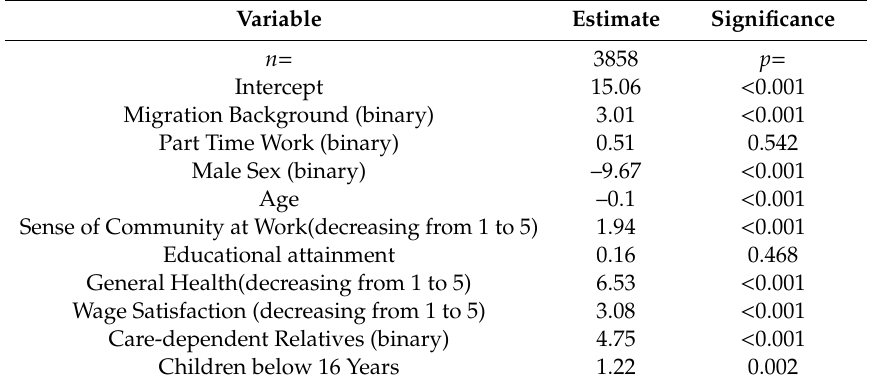
Table 2. Coe ffi cients of the regression of the CBI on migration background and third variables ( n = 3858). Variable